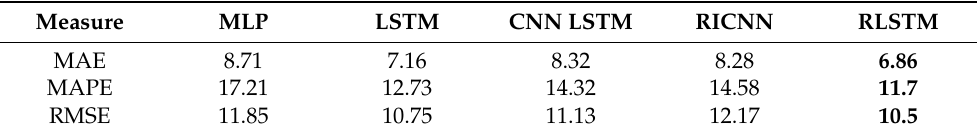
Table 4. Performance of the prediction models for the next-day peak-electricity demand.